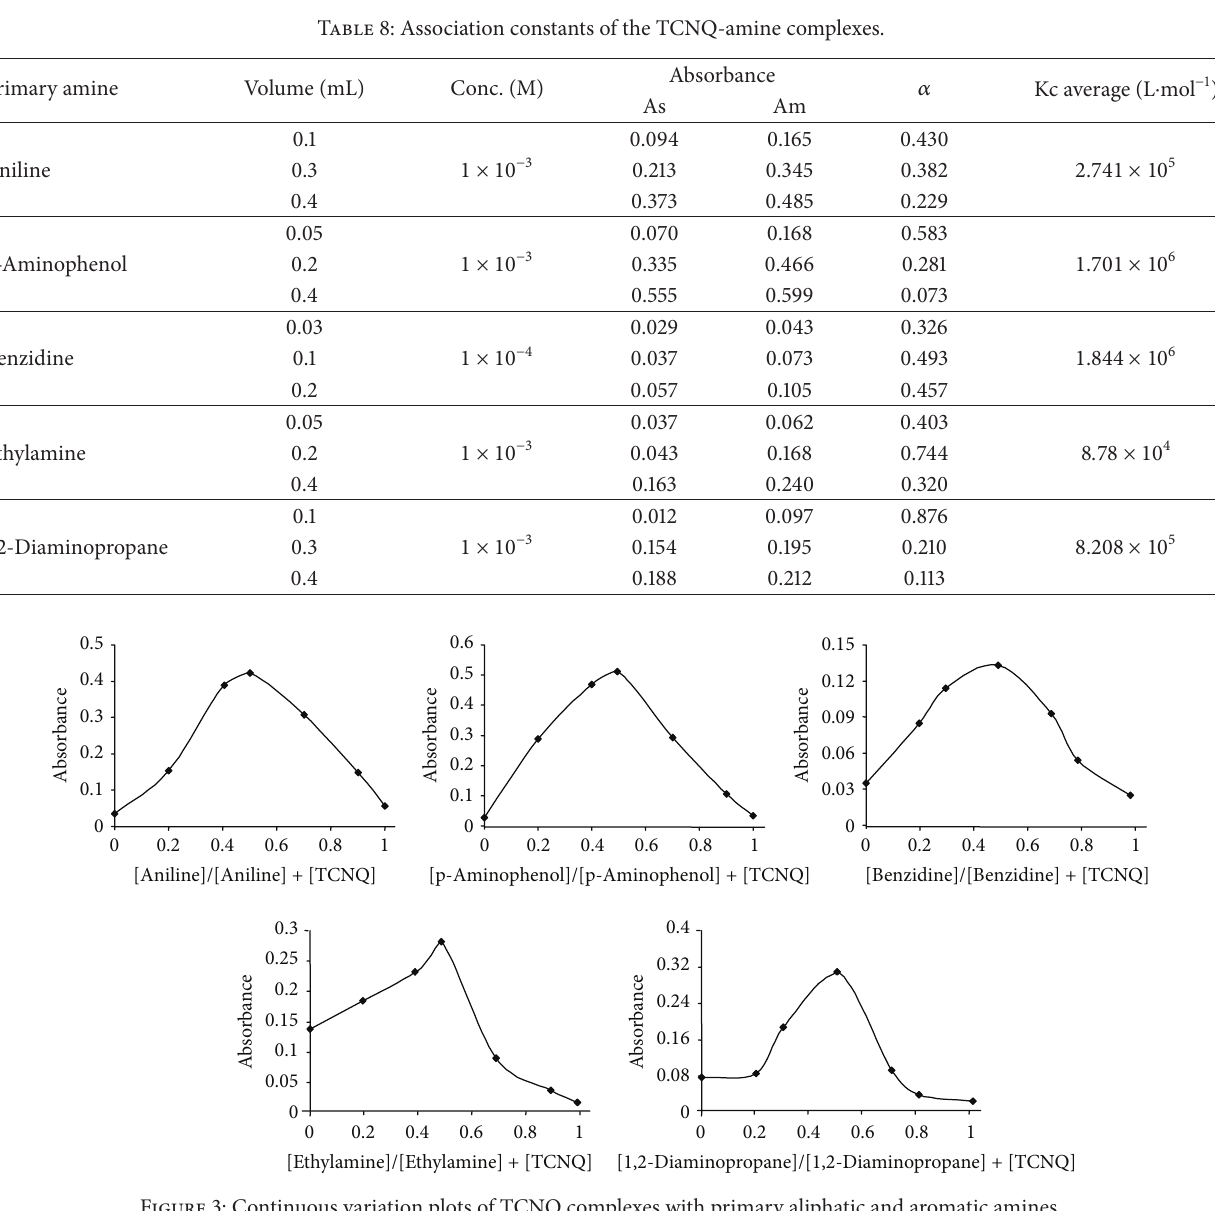
Figure 3: Continuous variation plots of TCNQ complexes with primary aliphatic and aromatic